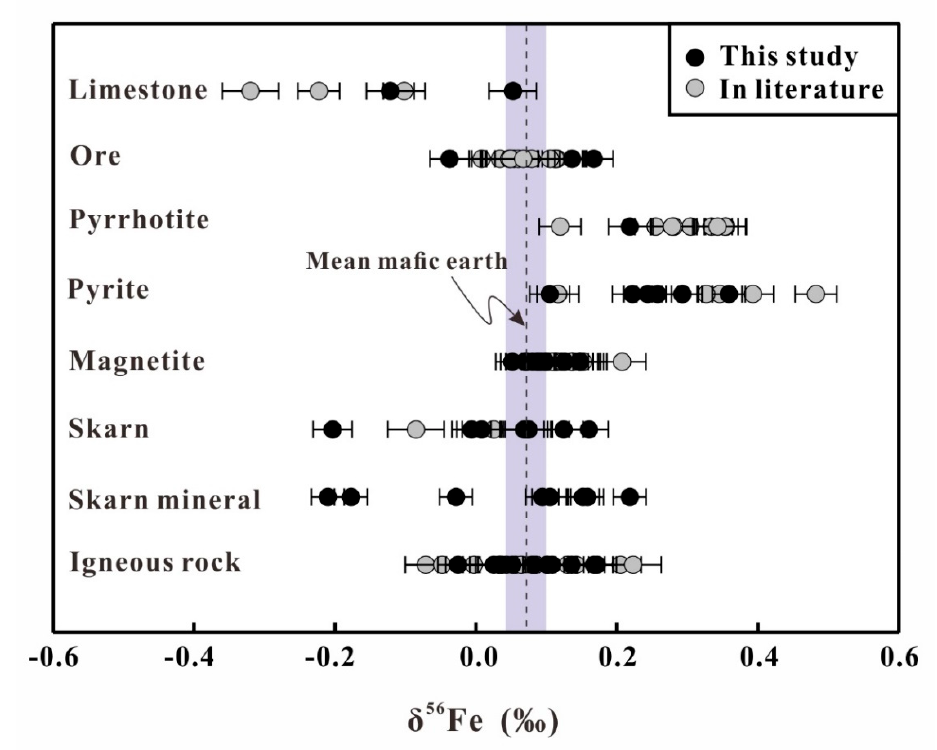
Figure 4. δ 56 Fe of whole rocks and mineral separates from the Han-Xing Fe skarn deposit. Data from this study are shown by black circles. Data from published literature are shown by gray circles [12,34]. Skarn minerals, magnetite and sulfides are picked from skarn and ores. The shaded area corresponds to the Fe isotopic composition (0.07 ± 0.03) of the mean mafic earth defined in Literature [30]. Error bars indicate 95% confidence interval (CI) of the mean.